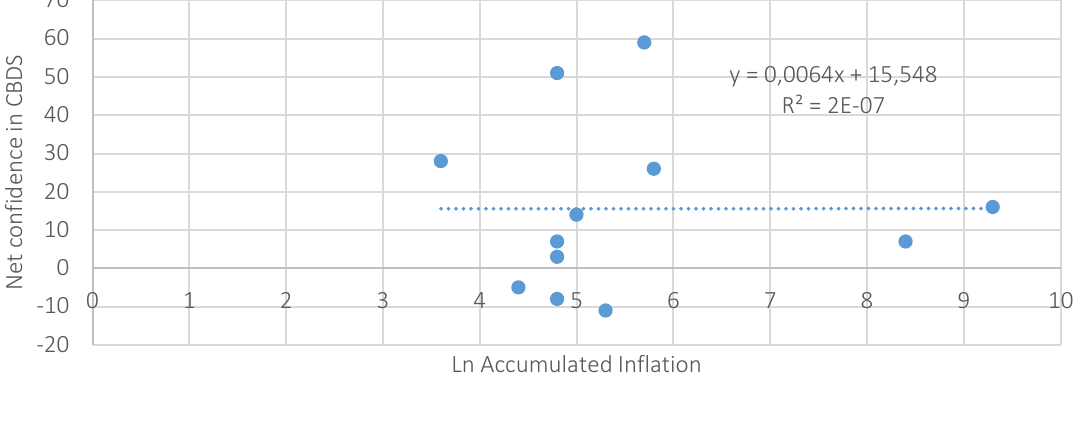
Figure D1. Confidence in CBDC and inflationary experience